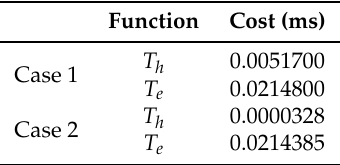
Table 4. Execution-time comparison criteria. The cost is presented in milliseconds (ms). T h represents a hash function execution, and T e the AES encryption/decryption execution.